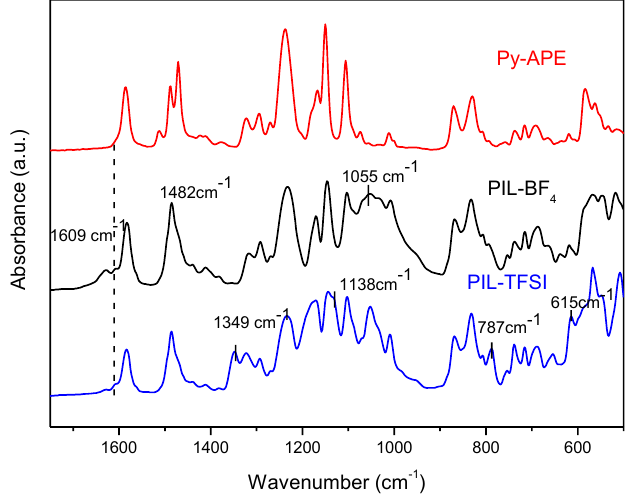
Figure 2. FT-IR spectra of precursor polymer Py-APE and its corresponding PILs with different counter